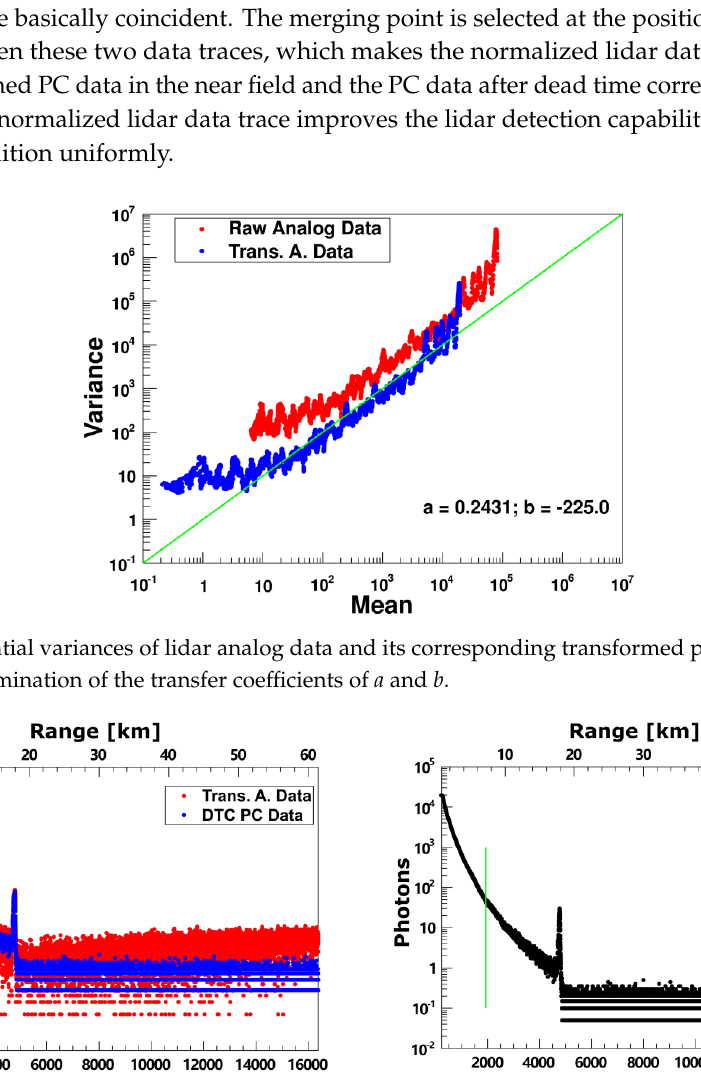
Figure 12. ( a ) Matching conditions between the transfer photon-counting data and the photon-counting data after dead time correction; ( b ) normalized lidar data trace constructed with the transformed PC data in near field and the photon-counting data in the far field. The green line marks the merging point.